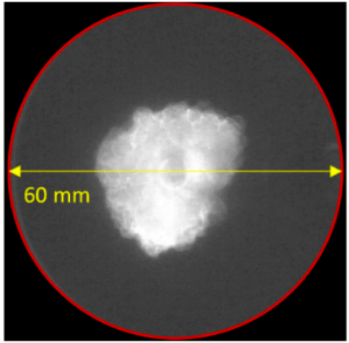
Figure 3. Area of the combustion chamber framed by the high-speed camera through the optical access (diameter equals to 60 mm).